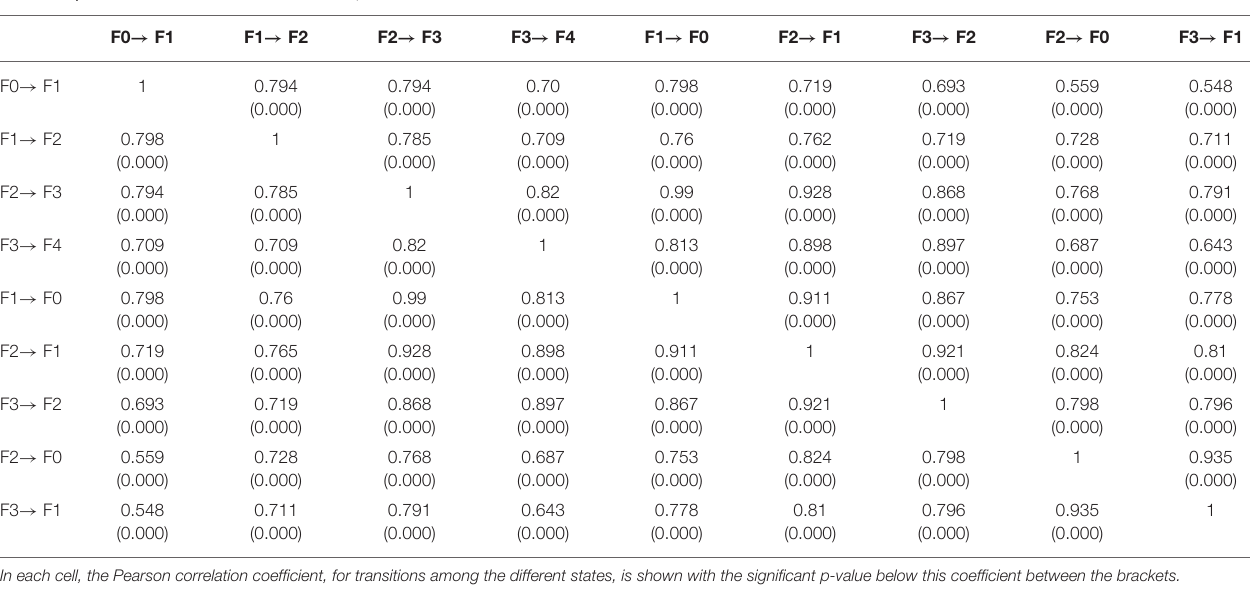
TABLE 3 | Correlation between the different response variables.